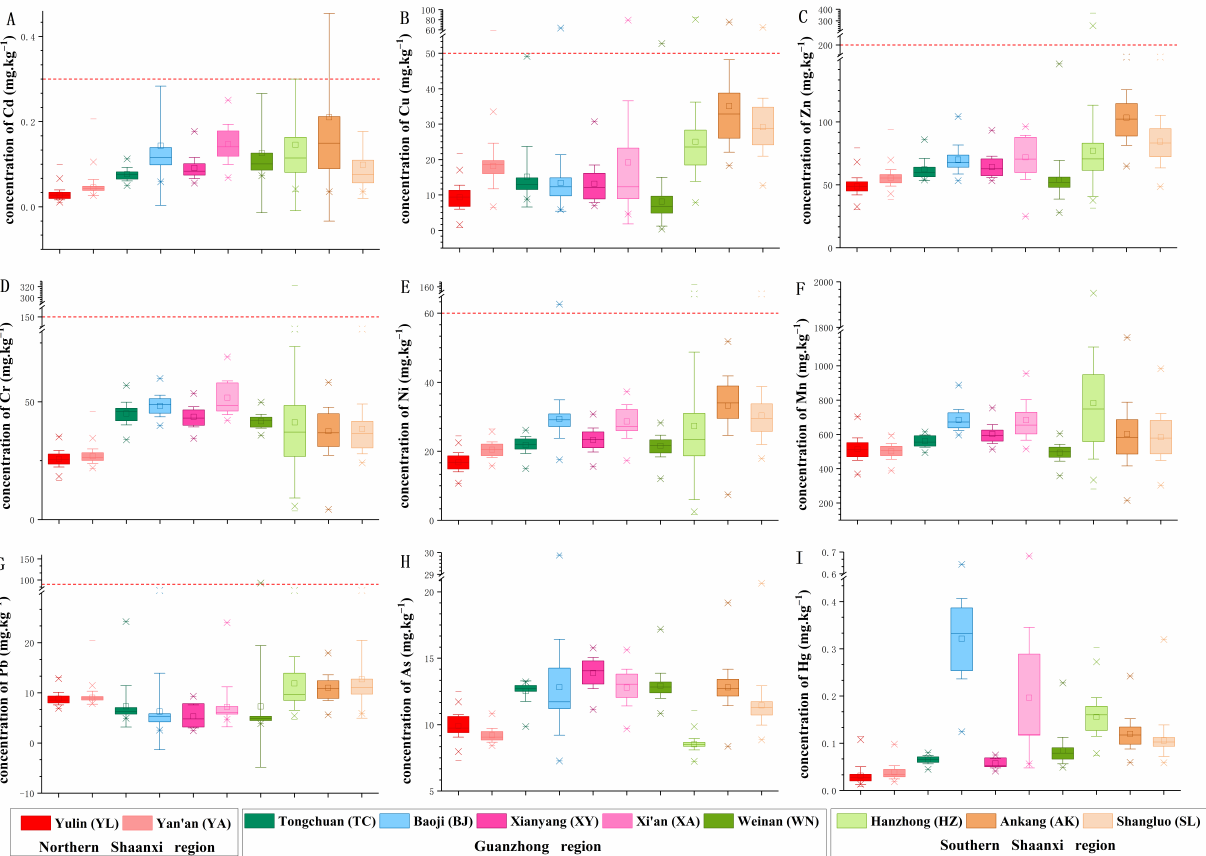
Figure 2. The concentrations (means ± standard deviation) of Cd ( A ), Cu ( B ), Zn ( C ), Cr ( D ), Ni ( E ), Mn ( F ), Pb ( G ), As ( H ), and Hg ( I ) in farmland soil of Shaanxi Province. The red lines indicate the risk screening value of the National Standard (GB 15618-2018) of the People’s Republic of China. The abbreviations are as follows: Yulin (YL, red), Yanan (YA, 50% red), Tongchuan (TC, dark cyan), Baoji (BJ, 50% dark cyan), Xianyang (XY, pink), Xi’an (XA, 50% pink), Weinan (WN, olive), Hanzhong (HZ, 50% olive), Ankang (AK, orange), and Shangluo (SL, 50%